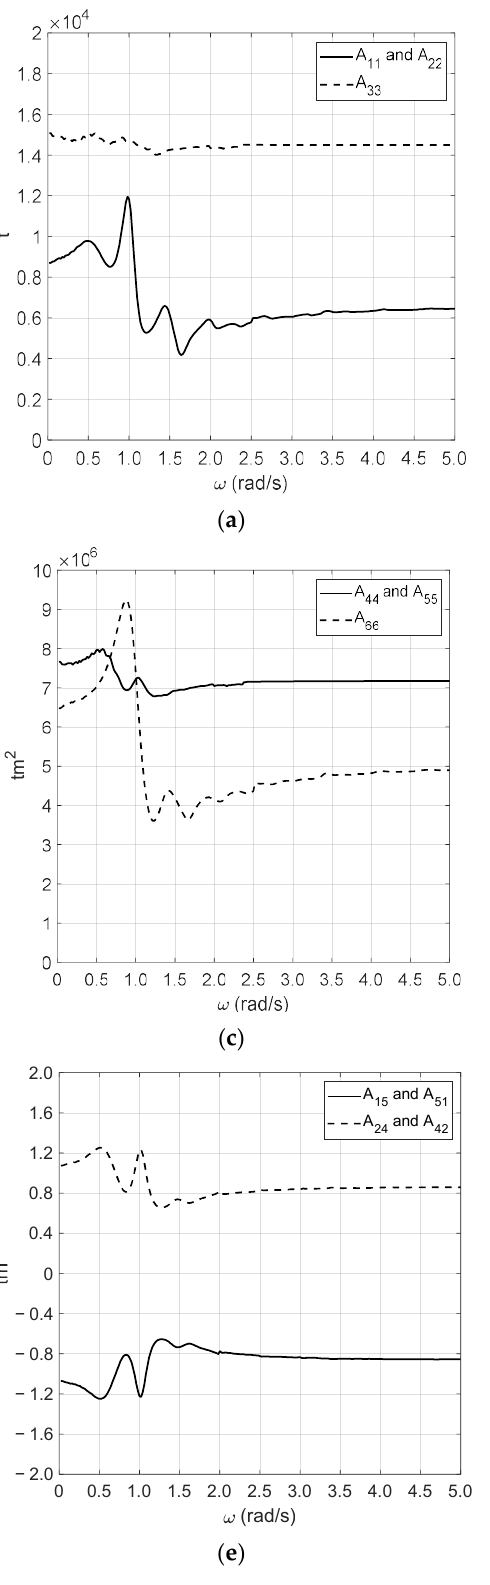
Figure A2. Added masses and radiation dampings of the OC4-DeepCWind platform. ( a ) Surge/sway and heave added masses; ( b ) surge/sway and heave radiation dampings; ( c ) roll/pitch and yaw added masses; ( d ) roll/pitch and yaw radiation dampings; ( e ) surge/pitch and sway/roll added masses; ( f ) surge/pitch and sway/roll radiation